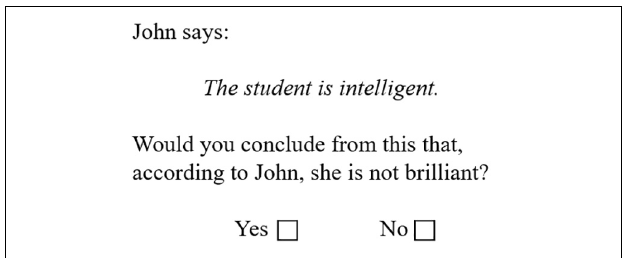
FIGURE 1 | Sample item from van Tiel et al. (2016) – Experiment